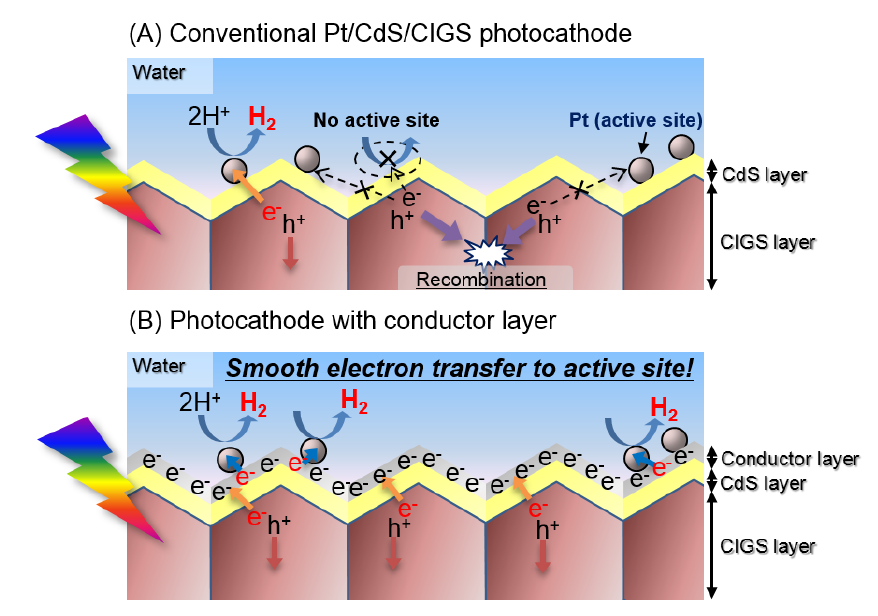
Figure 4. Proposed mechanisms for hydrogen evolution on the surfaces of CIGS photocathodes with and without a conductor layer. Adapted from Reference [47] with permission (Copyright The Royal Society of Chemistry 2015).